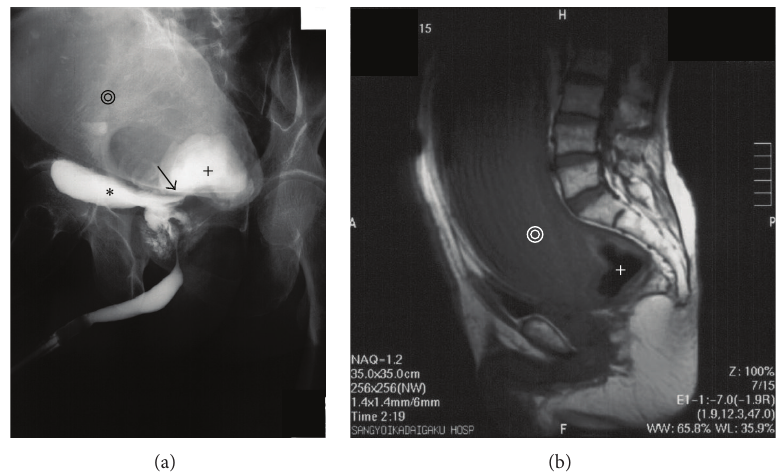
Figure 2: (a) Retrograde urethrography indicated a dilated rectum (black double concentric circles), urinary bladder (black star), and rectourethral fistula between the prostate urethra and lower rectum (black arrow) with stones (black cross). (b) Magnetic resonance imaging (MRI) revealed a megarectum (white double open circles) with stones (white cross).